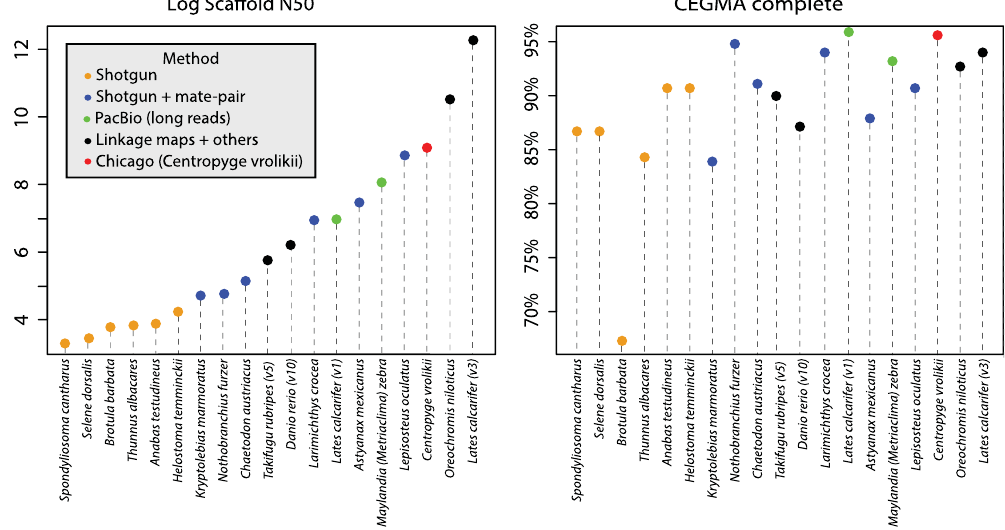
Figure 4. Comparison of the Pearlscale Pygmy Angelfish assembly with 18 other recently published fish assemblies. Assemblies are ranked by scaffold N50 and color coded by type of data that was utilized to generate the assembly (See also information in Table S3). Only scaffolds 1,000 bp and longer were considered for calculating scaffold N50 and CEGMA